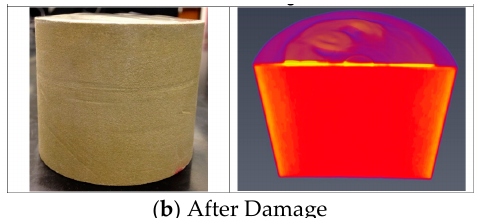
Figure 8. Photos of the original core and computer tomography (CT) images before damage ( a ) and after damage ( b ).